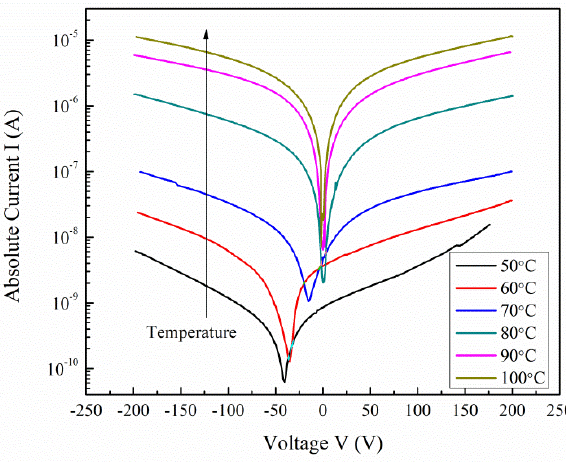
Figure 5: I-V Characteristic curves for S2 (10 vol.% choloroform) nanocomposites at different temperatures